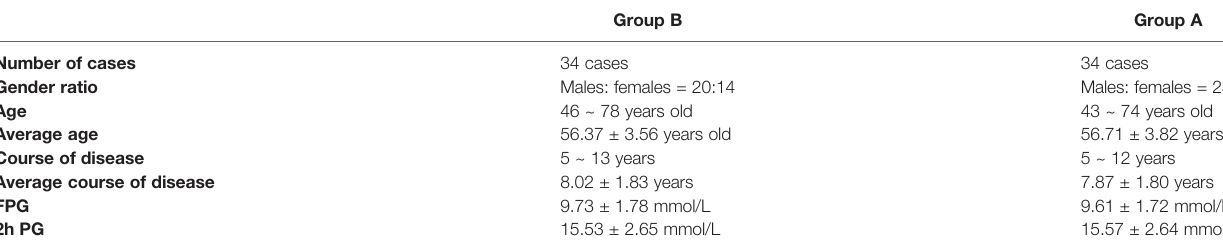
TABLE 1 | General data of